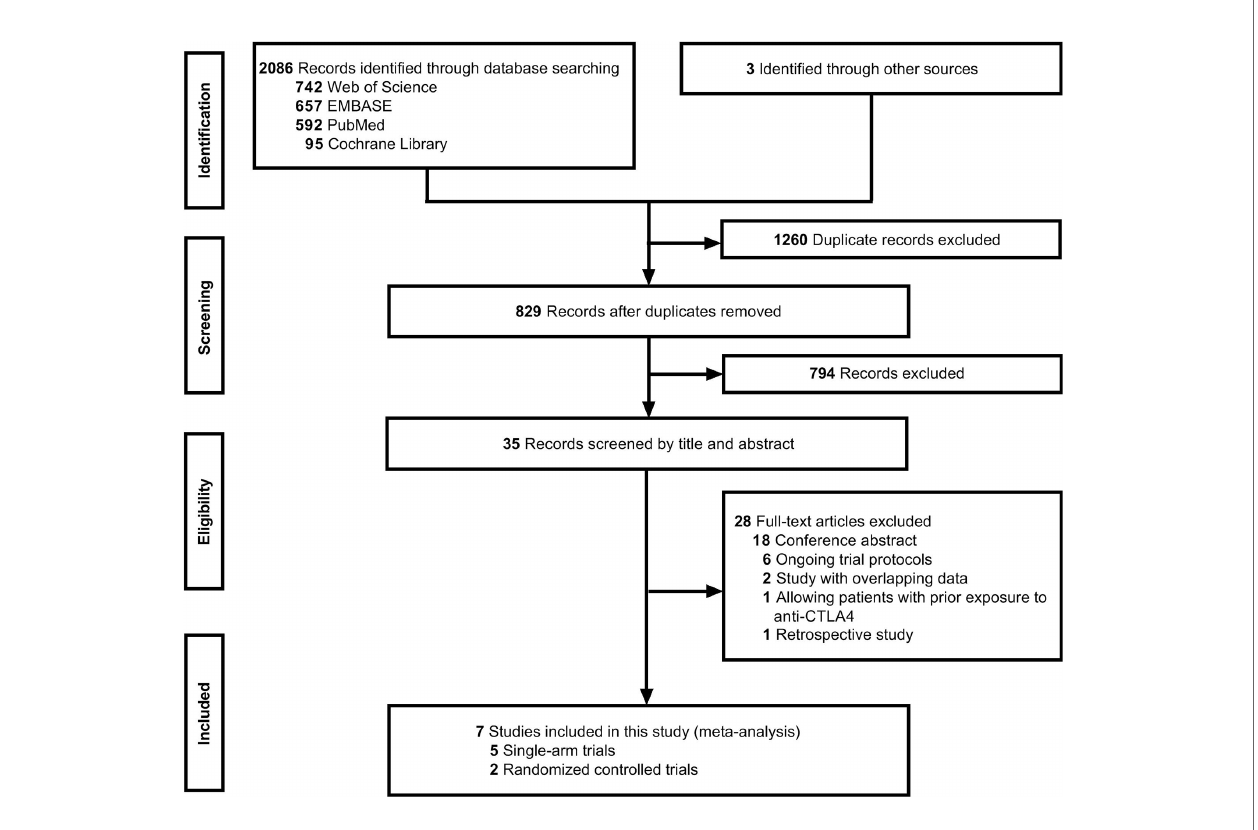
FIGURE 1 | Study selection followed by PRISMA diagram.